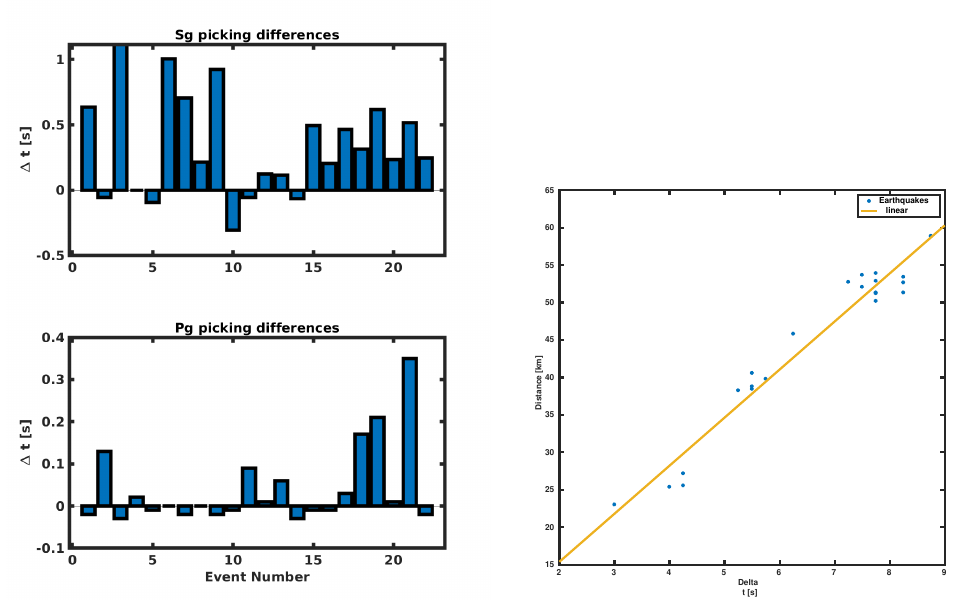
Figure 7. Right panel: The picked time differences compared with the hypocentral distance provided by the INGV localization and the linear regression. Left panel, on top, the time difference in [s] from INGV to AR-pick Pg onset. The bottom panel represents the time difference in [s] from INGV to 4C polarization Sg onset